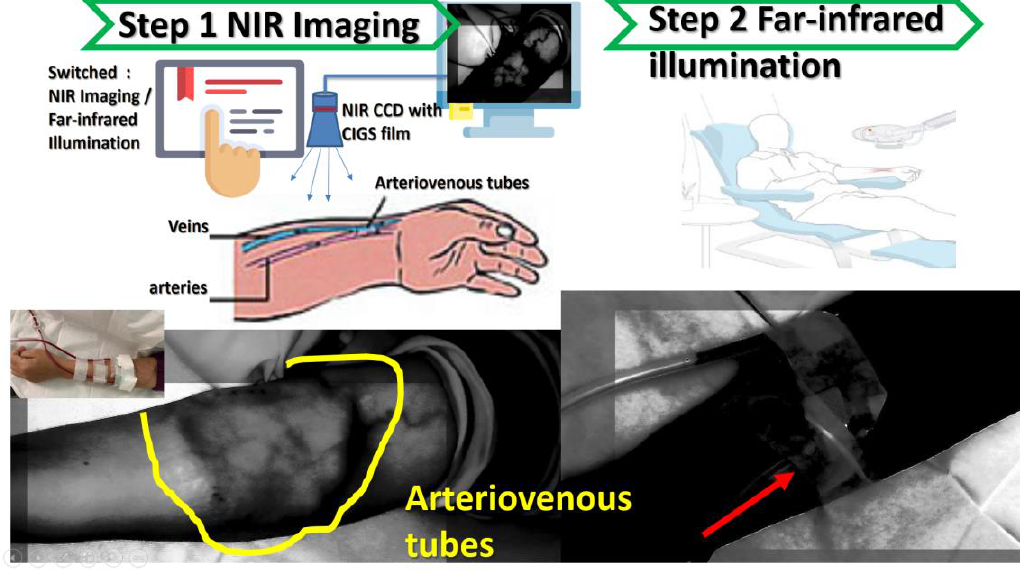
Figure 11. The diagram of both NIR for veins detection and far infrared for therapeutic effect.